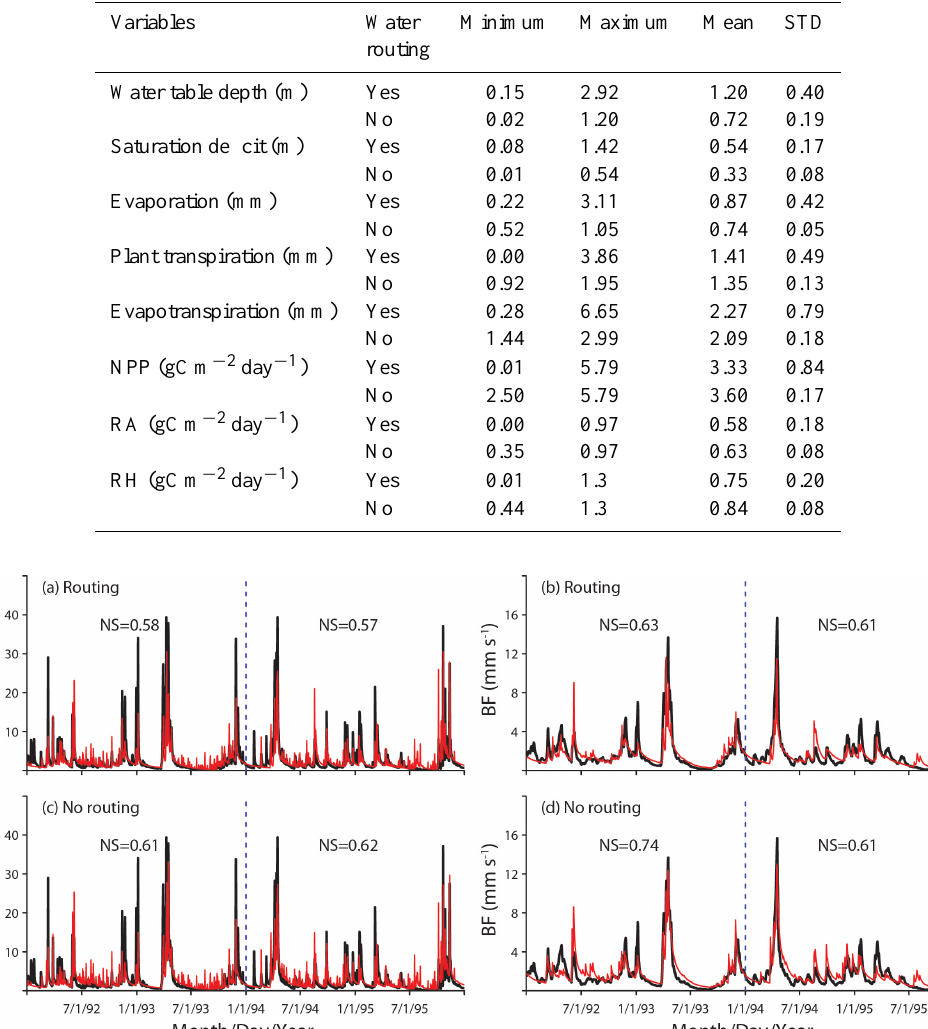
Table 2. Comparison of simulated hydrological and ecological variables between the two contrasting simulations: with vs. without water routing. Variables